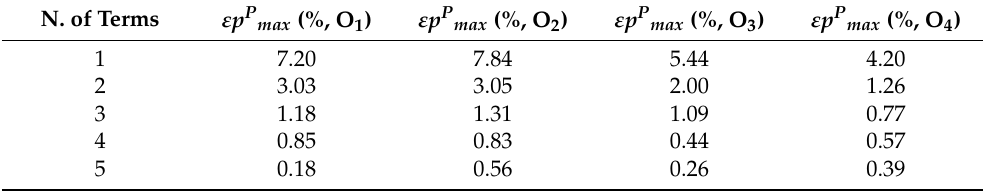
Table 7. Maximum polarization percentage remaining errors after application of each multiplicative term to the fp P f